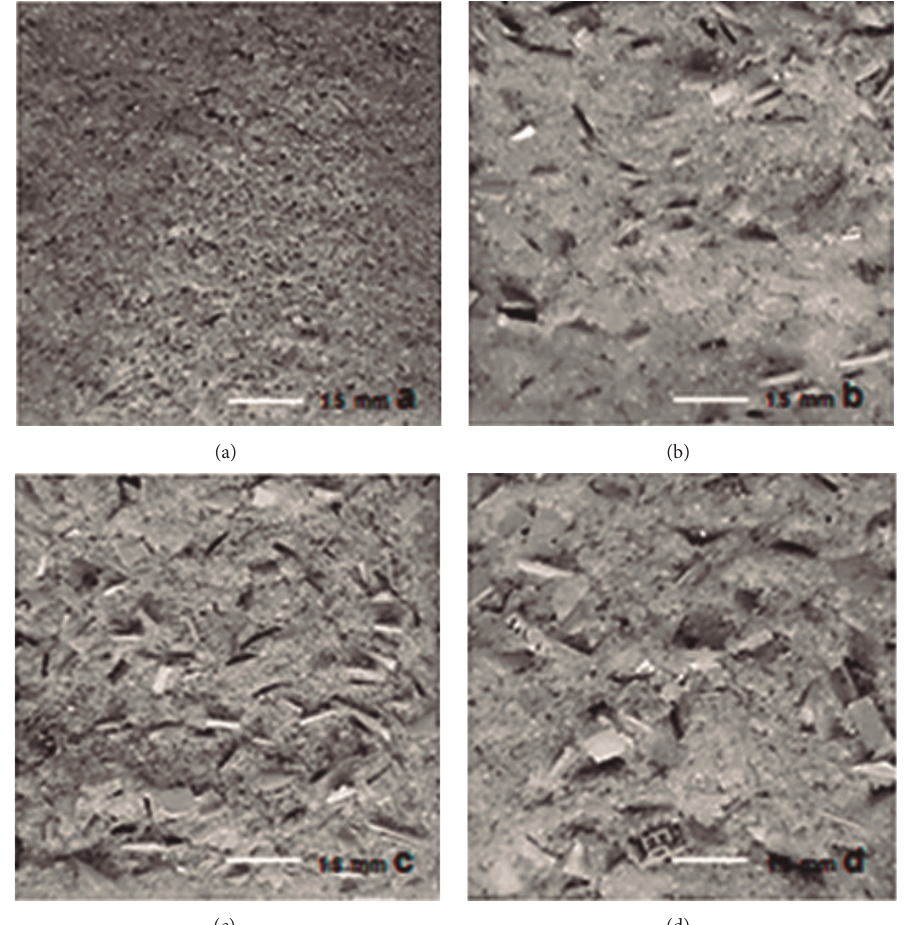
Figure 7: Polymer concrete without Tetra Pak particles (a) and with 1wt% at different size; (b) 0.85 mm, (c) 1.40mm, and (d) 2.36